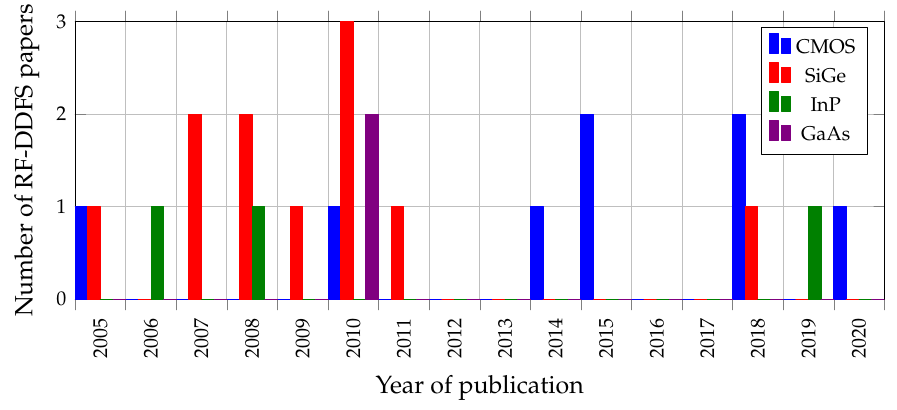
Figure 15. Number of fully characterized published RF-DDFS versus year of